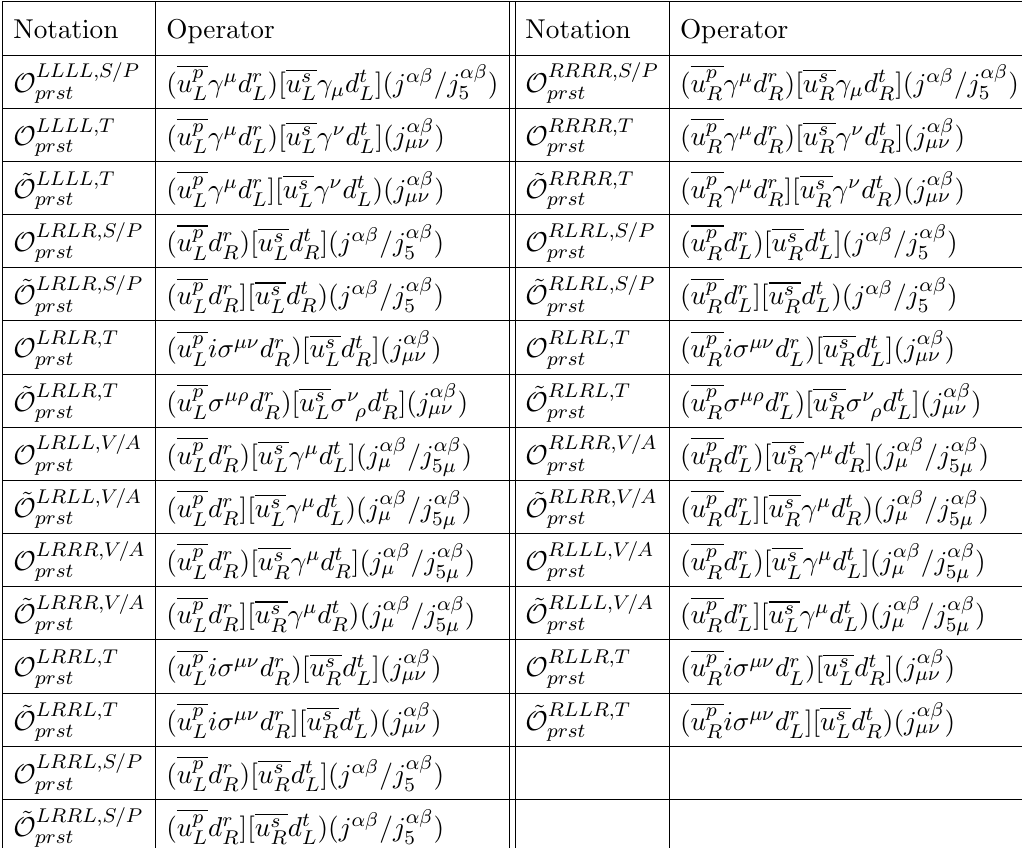
Table 1 . Dim-9 basis operators with L = (cid:0) 2. The chiralities of quarks and the Lorentz structure of the lepton bilinear are shown as superscripts of O and the (cid:13)avors of quarks as subscripts. ~ O di(cid:11)ers from O only in color contraction. A factor of i is associated with (cid:27) (cid:22)(cid:23) so that the relevant anomalous dimension matrix elements in section 3 are